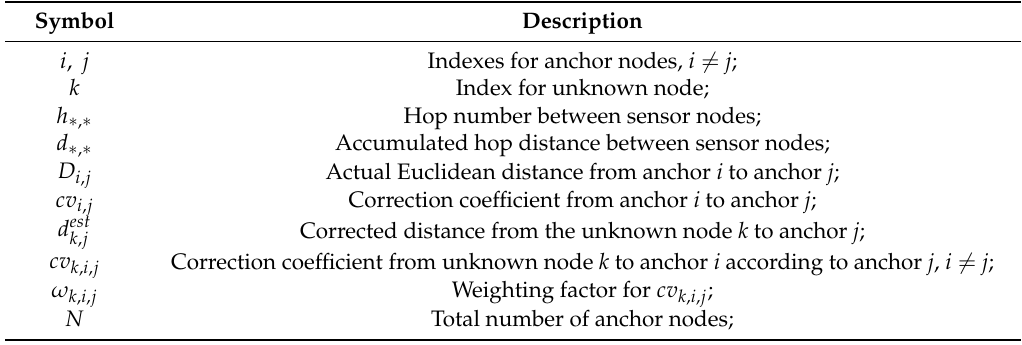
Table 1. Symbol description for some DV_Distance improvement algorithms.